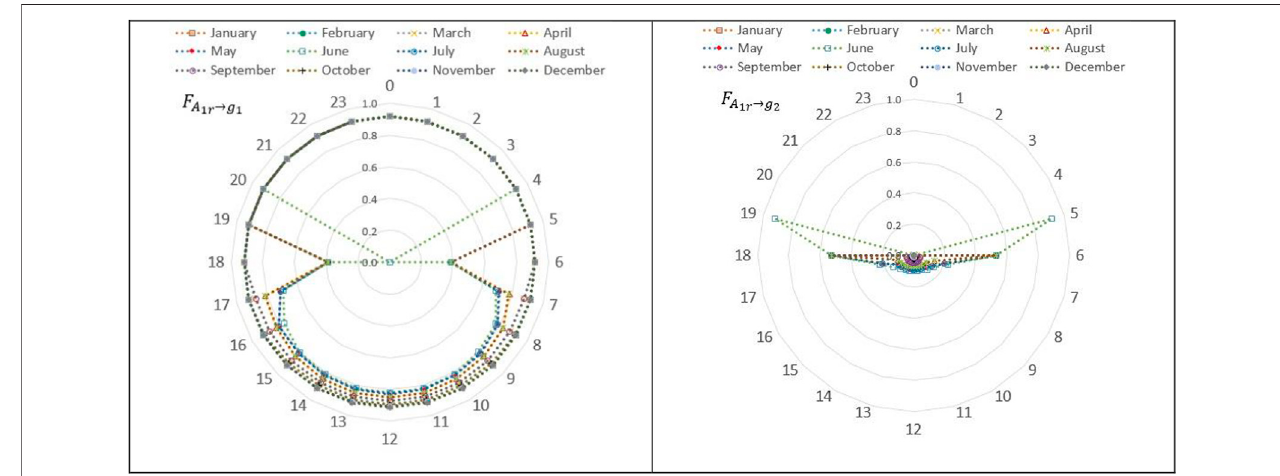
FIGURE 16 | Hourly values of F A